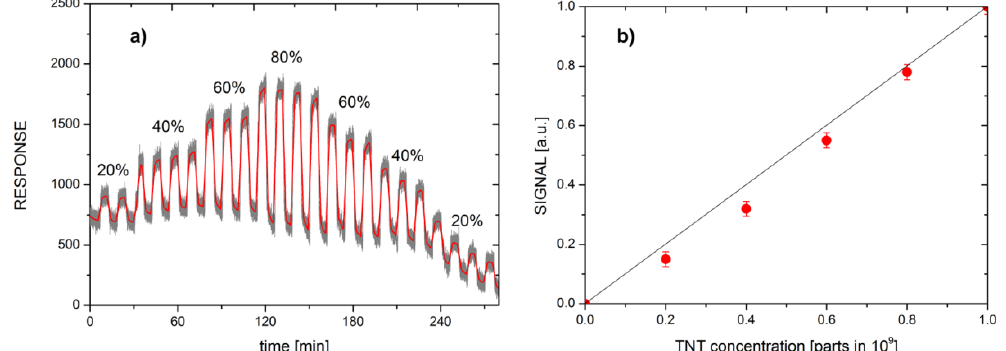
Figure 15. Response of a CE measurement system using comb sensors, surface-functionalized with APS (CE-APS), to various concentrations of TNT vapours in the carrier gas N . ( a ) Time-dependence of the CE-APS response to the gas, switched 2 between pure N and N with added TNT vapours of different concentrations. The 2 2 concentration of TNT was first increased in steps of 20% and then decreased back. Black symbols represent raw data, red symbols are 2000 point averaged data. ( b ) Signal of the CE-APS measurement system as a function of peak concentration of TNT in N